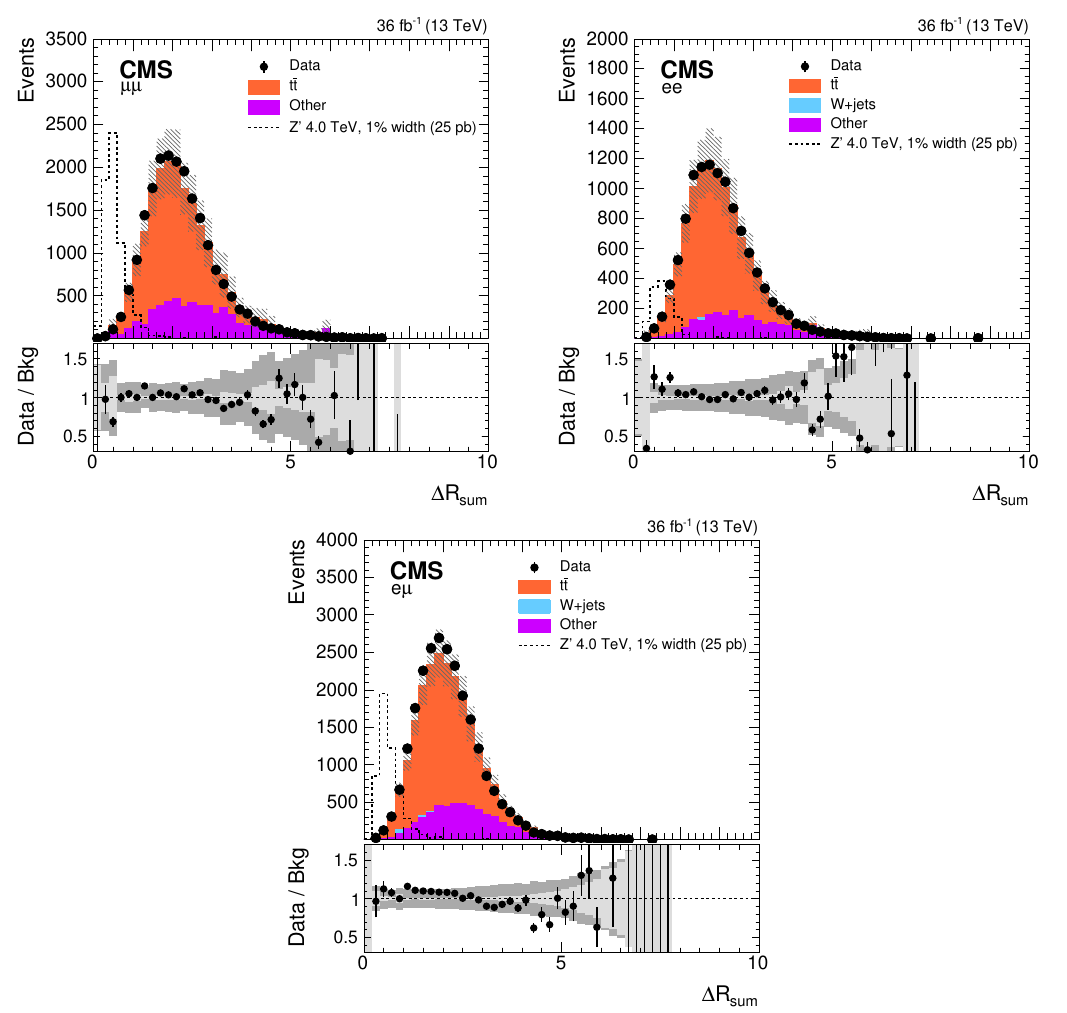
Figure 2 . Distributions of (cid:1) R sum in (cid:22)(cid:22) (upper left), ee (upper right), and e (cid:22) (lower) events. The contribution expected from a 4 TeV Z 0 boson, with a relative width of 1%, is shown normalized to a cross section of 25 pb. The hatched band on the simulated distribution represents the statistical and systematic uncertainties. The lower panels in each plot show the ratio of data to the SM background prediction and the light (dark) gray band represents statistical (systematic) uncertainty. The error bars on the data points indicate the Poisson statistical